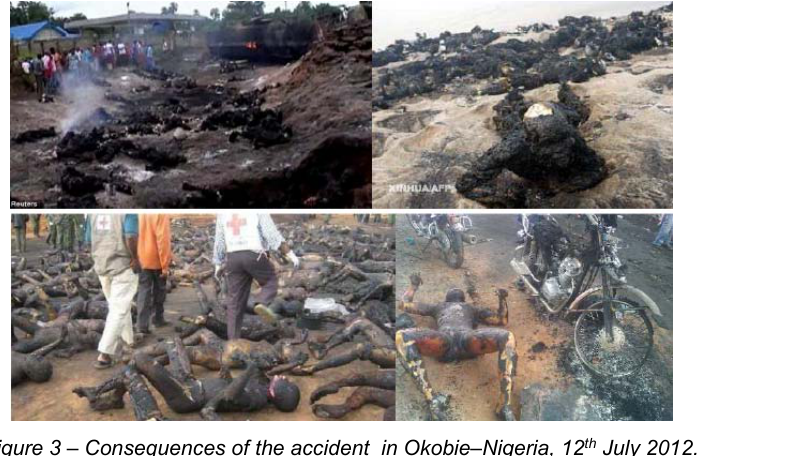
Figure 3 – Consequences of the accident in Okobie–Nigeria, 12 th July 2012. (Jankovi ć ,